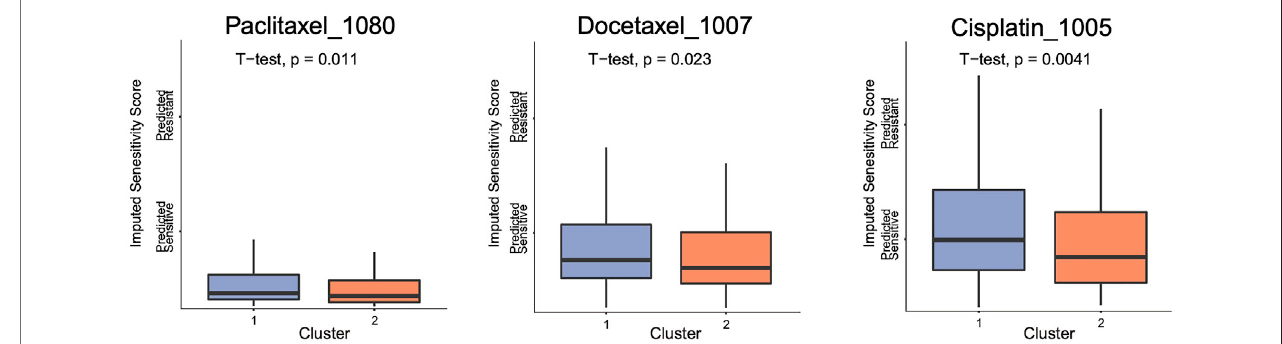
FIGURE 6 | The boxplot of imputed sensitivity score of three chemotherapeutic drugs in two clusters.